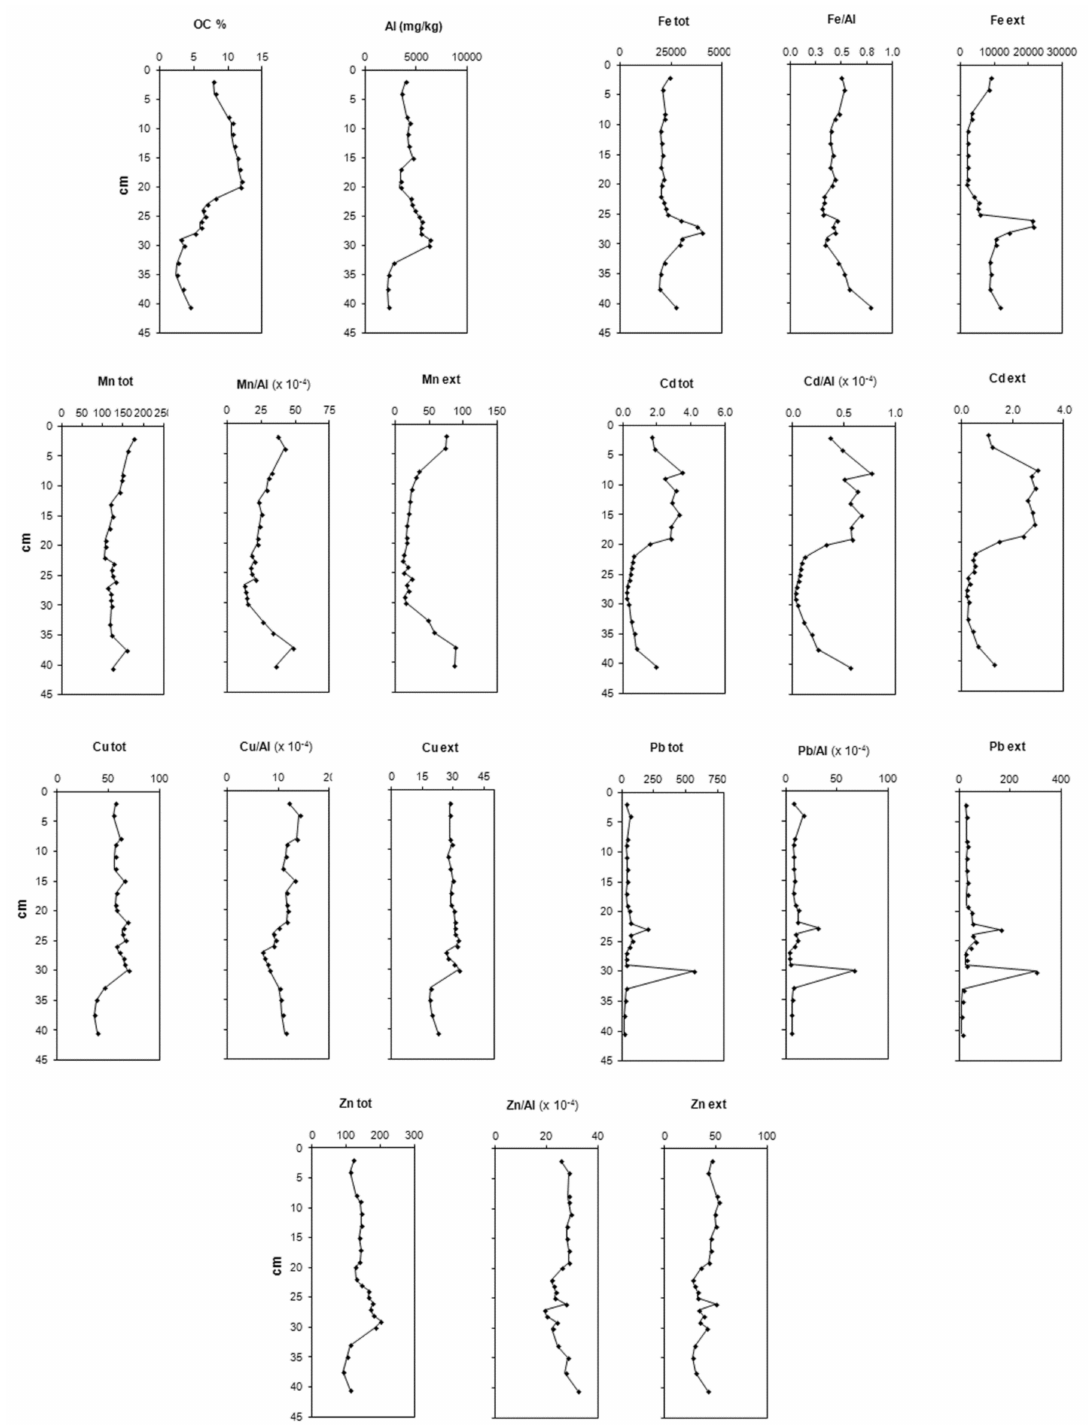
Figure 7. Vertical distributions of total, 0.5N HCl extractable, and normalized to Al metal contents in the core